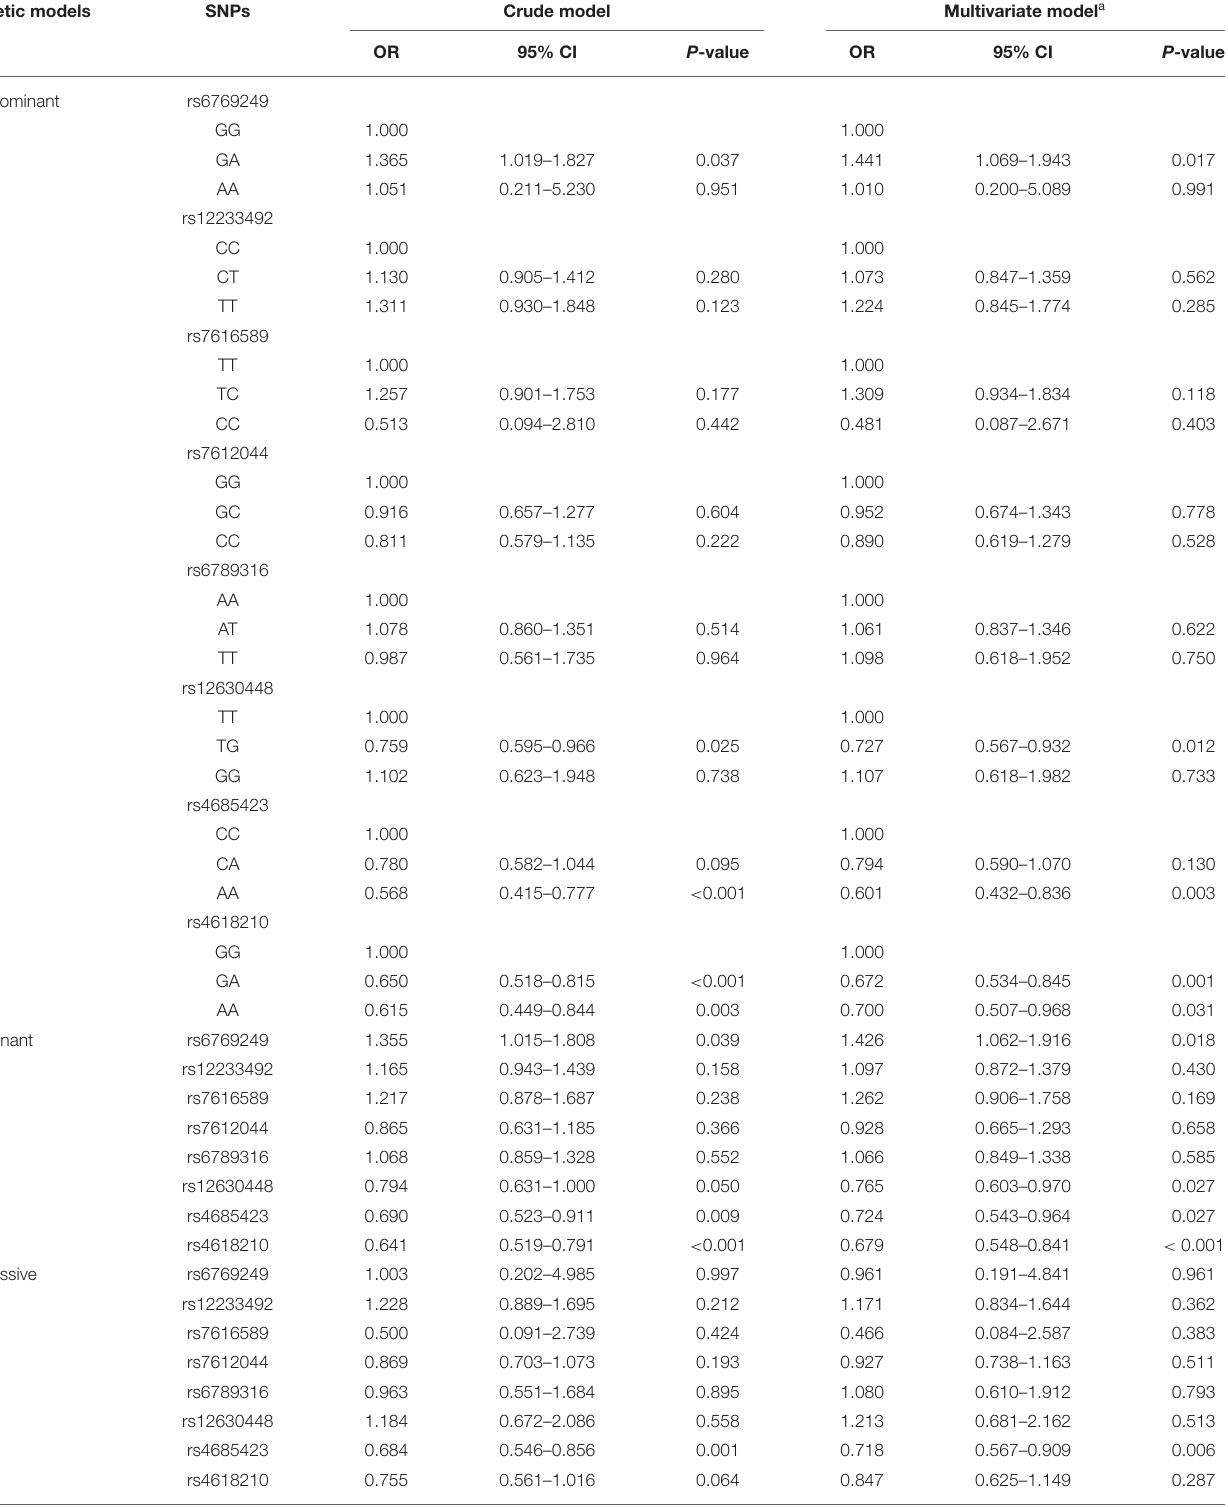
TABLE 2 | Association between PLCL2 and risk of IS plus MetS. Genetic